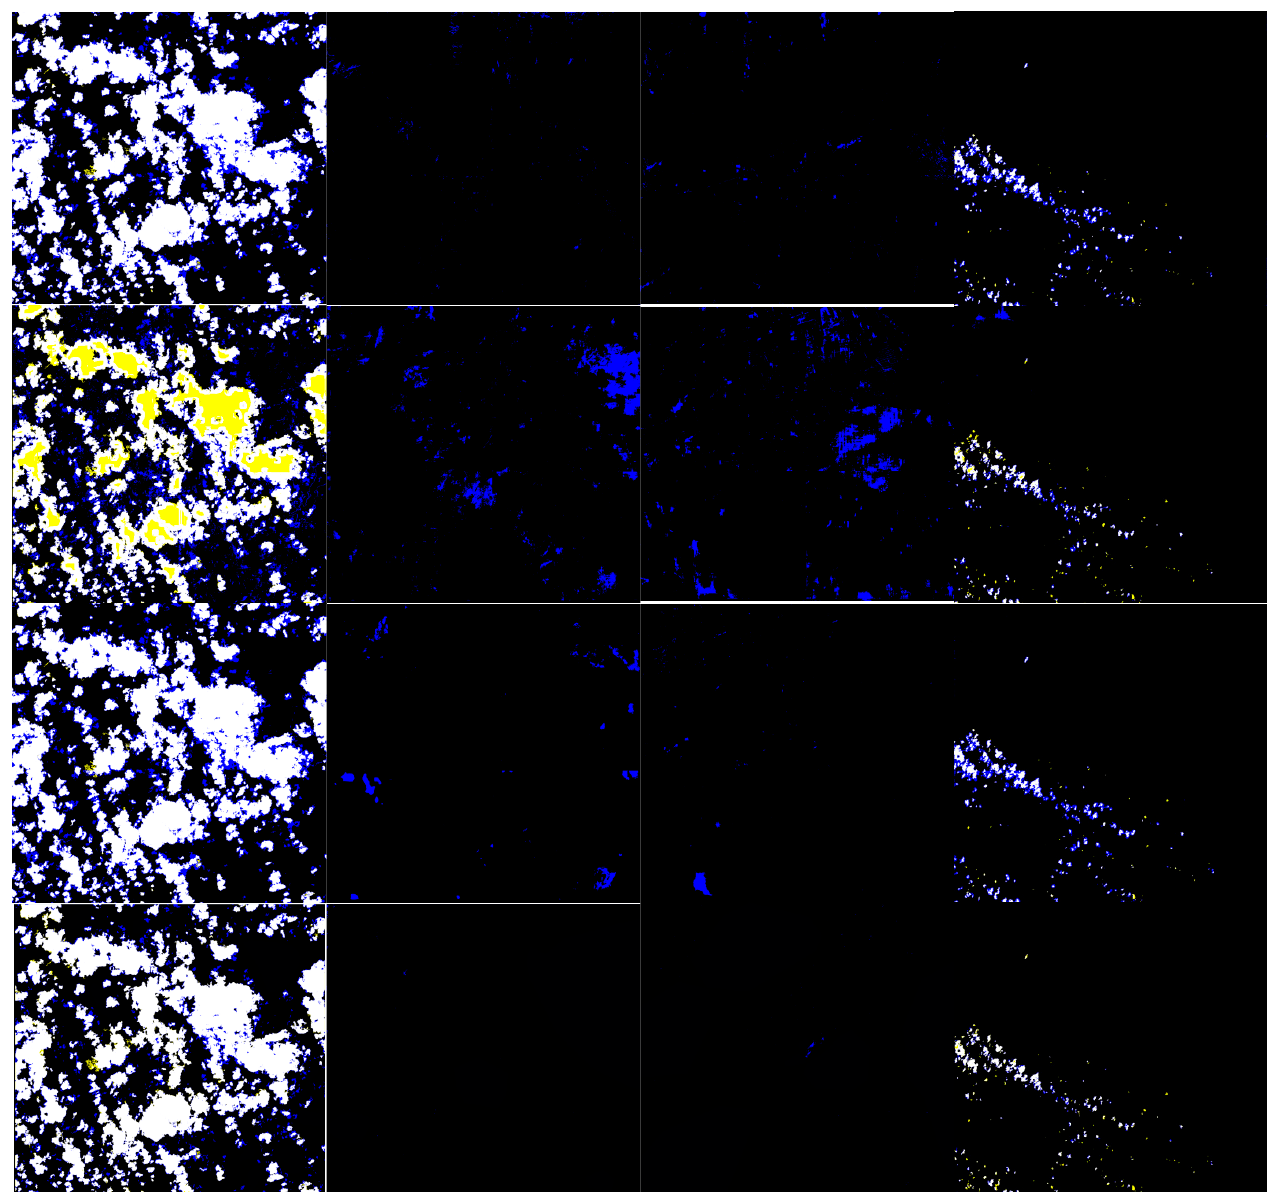
Figure 6. Comparison of cloud detection results of different algorithms (from top to bottom, true-color image map, ground truth, DeeplabV3+ extraction result, MT-Unet, MSCFF extraction results, CDNet extraction results, RS-net, GCDB-UNet, and extraction result of our algorithm. The yellow areas indicate the missed extracted pixels and the blue areas indicate the wrong extracted pixels, the letter A/B represents the subregion of the whole picture, we will discuss different algorithms performance in this